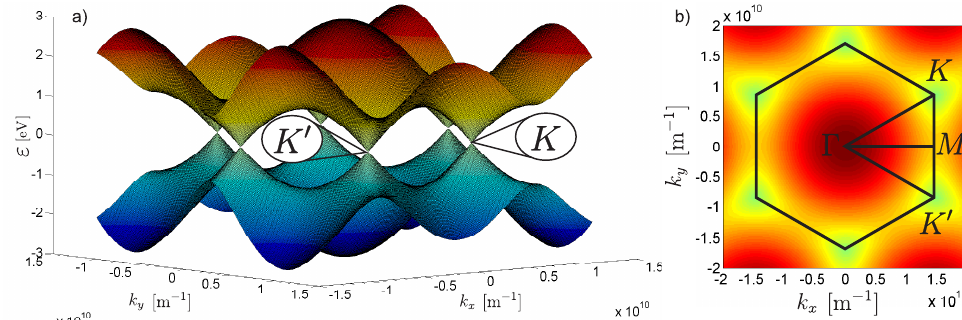
Figure 1. ( a ) First Brillouin zone in graphene with marked points, ( b ) Γ —center of the zone, M —center of the edge, K and K (cid:48) are the nonequivalent Dirac